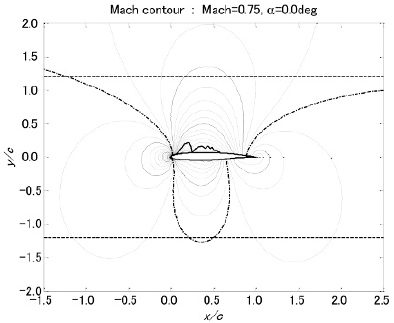
Figure 7. Mach contour with boundary condition A.